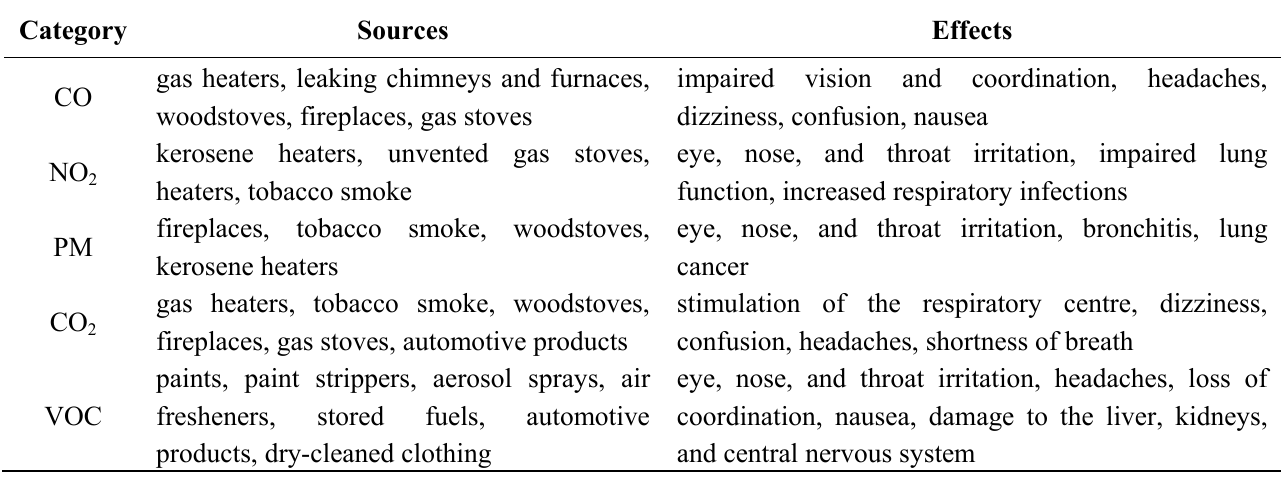
Table 1. Air pollutants and their effects on the human body